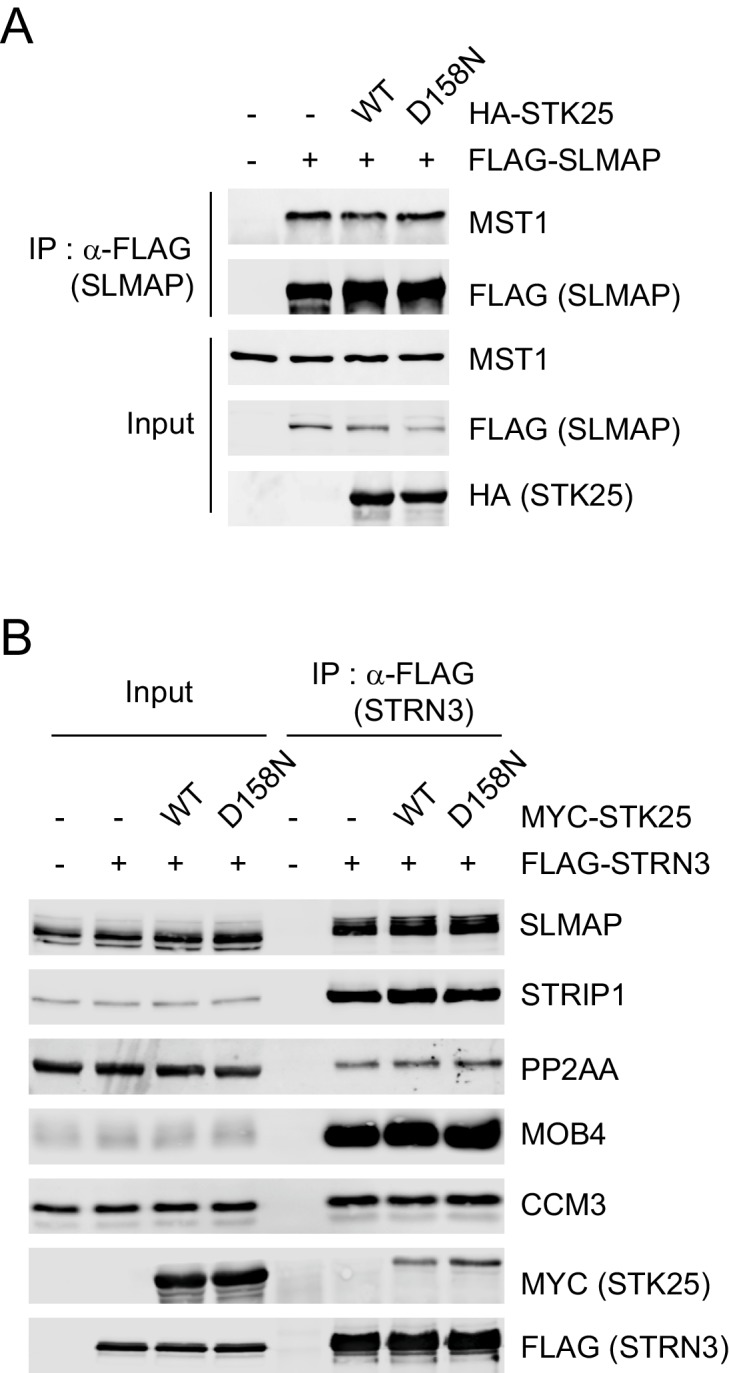
STK25 is not required for STRIPAK assembly or its interaction with MST1/2.(A and B) 293FT cells were co-transfected with the indicated plasmids. The total cell lysates (input) and anti-FLAG IP were subjected to immunoblotting analysis.